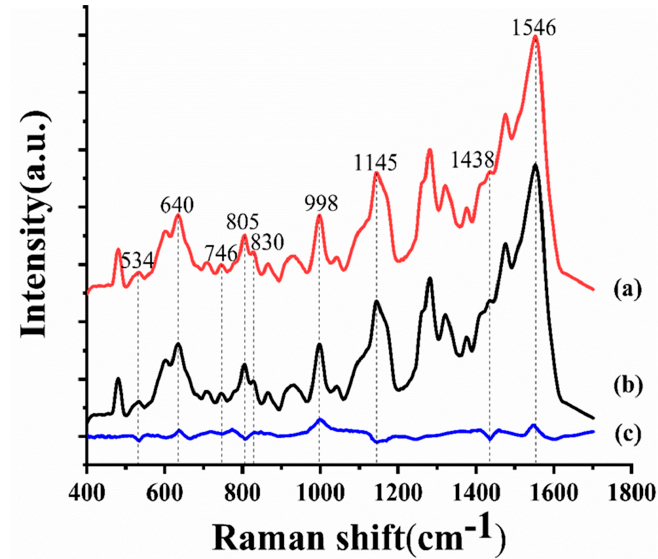
Figure 4. SERS spectral changes of HeLa cells treated with cordycepin in the late stage of apoptosis. ( a ) The average SERS spectrum of the control group; ( b ) the average SERS spectrum of the cordycepin- 48 h group; ( c) : spectral difference between (b) and (a). The x-axis is the Raman shift and y-axis is the intensities in arbitrary unit (a.u.).